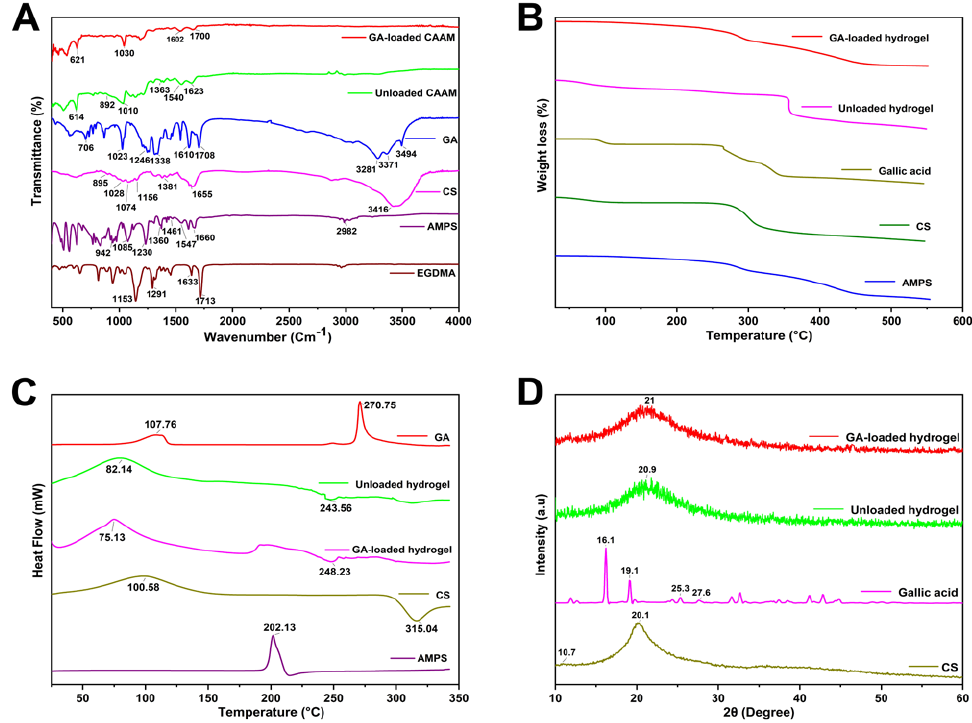
Figure 1. FTIR ( A ), TGA ( B ), DSC ( C ), and XRD ( D ) of CS- g -AMPS hydrogels and its components.